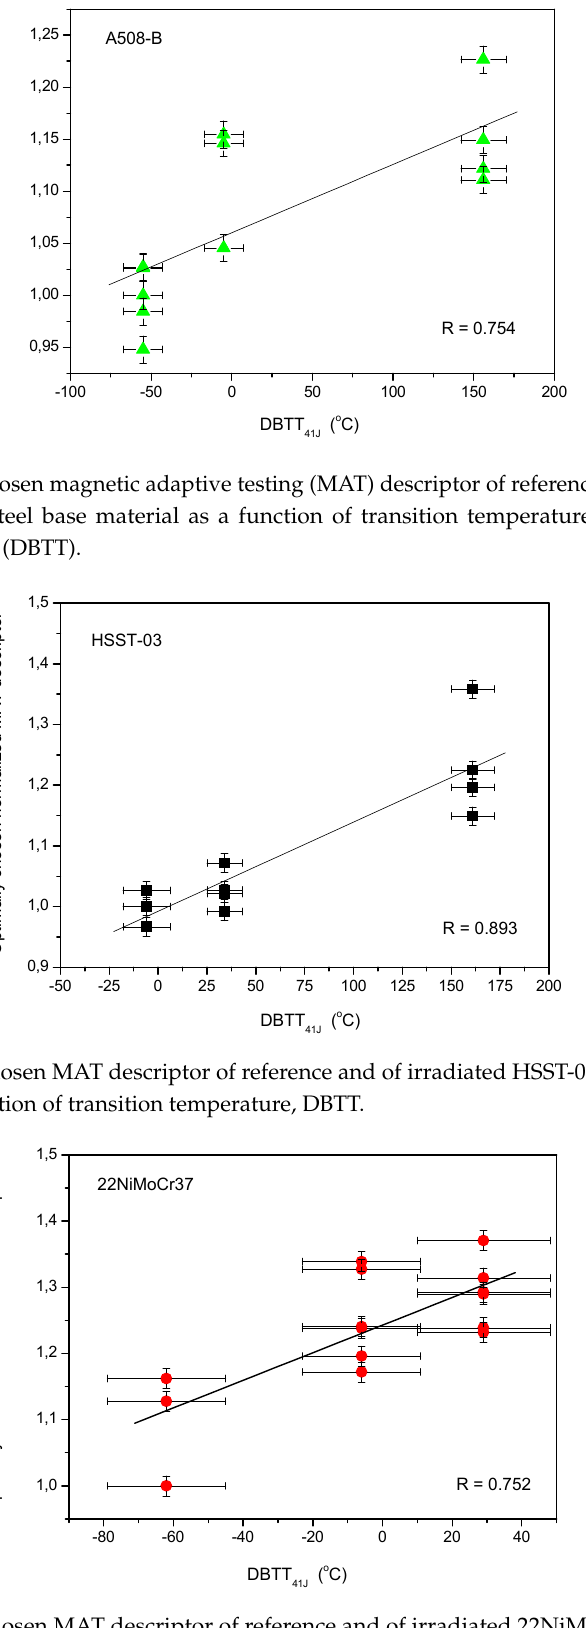
Figure 7. Optimally chosen MAT descriptor of reference and of irradiated 18MND type weld material as a function of transition temperature, DBTT. As it is seen in Figures 4–7, a linear or closely linear correlation can be observed in all four types of materials between MAT descriptor and transition temperature. The best fitting was obtained by linear fit indicated in the figures together with the value of regression factor, R. These results were expected on the basis of our previous experience and other literature data, e.g., [12,20,23]. The graphs above show how the magnetic descriptors are modified by neutron irradiation. This ratio, the normalized MAT descriptor at the maximum DBTT value is typically 30–40%, with respect to the reference (not irradiated) samples. This change in magnetic parameters seems to be large enough for a reliable and sensitive detection of neutron irradiation damage generated in the material.